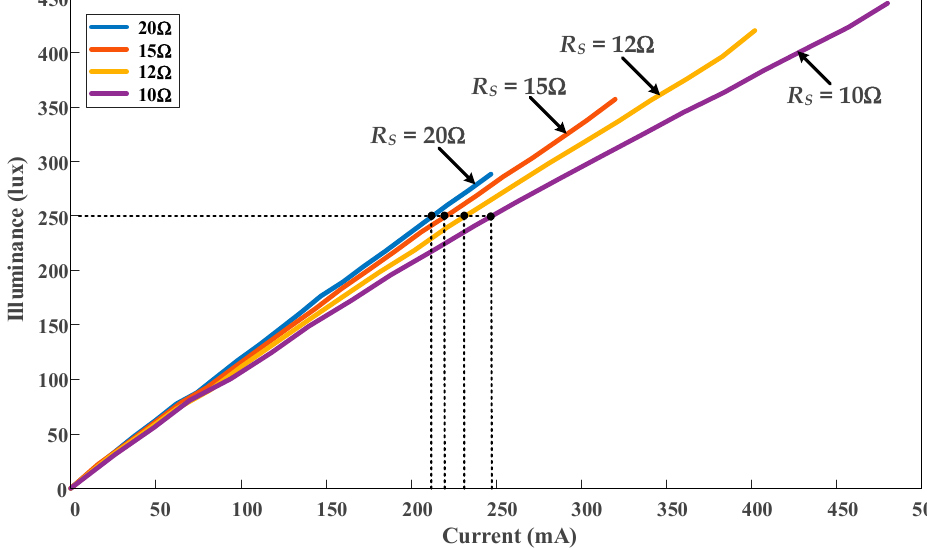
Figure 5. Measured current–illuminance curves for CXB1304 LED under different R S values.